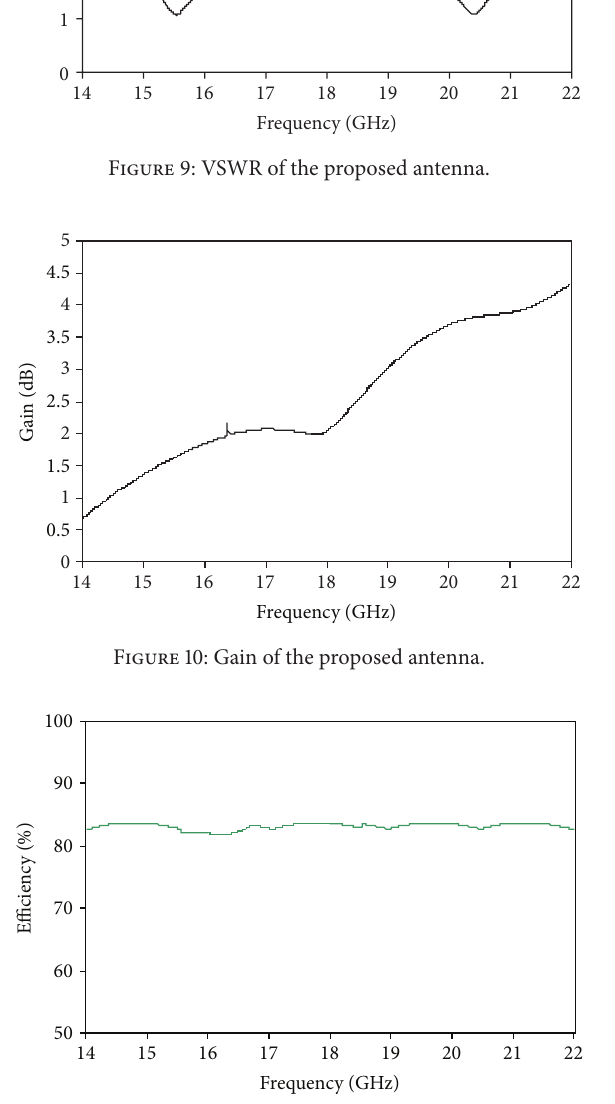
Figure 11: Radiation efficiency of the proposed